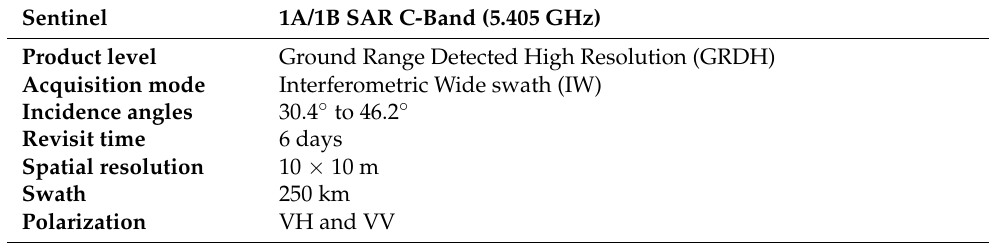
Table 1. Sentinel-1 data. The acquisition date is sorted by line corresponding to each month.